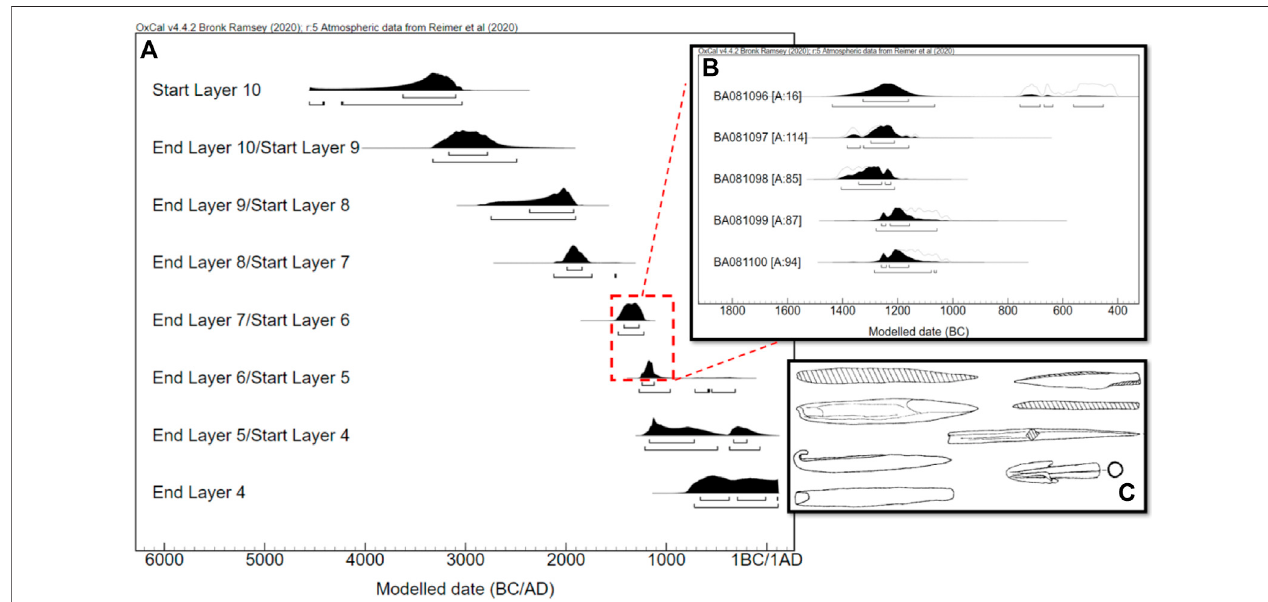
FIGURE 5 | Remodeling of the radiocarbon dates from Haimenkou ( (A) . the modeled start and end date for each stratigraphic layer at Haimenkou; (B) . the four radiocarbon dates assigned to the Layer VI; (C) . some metal objects recovered at Haimenkou; data source: Li and Min (2016)).